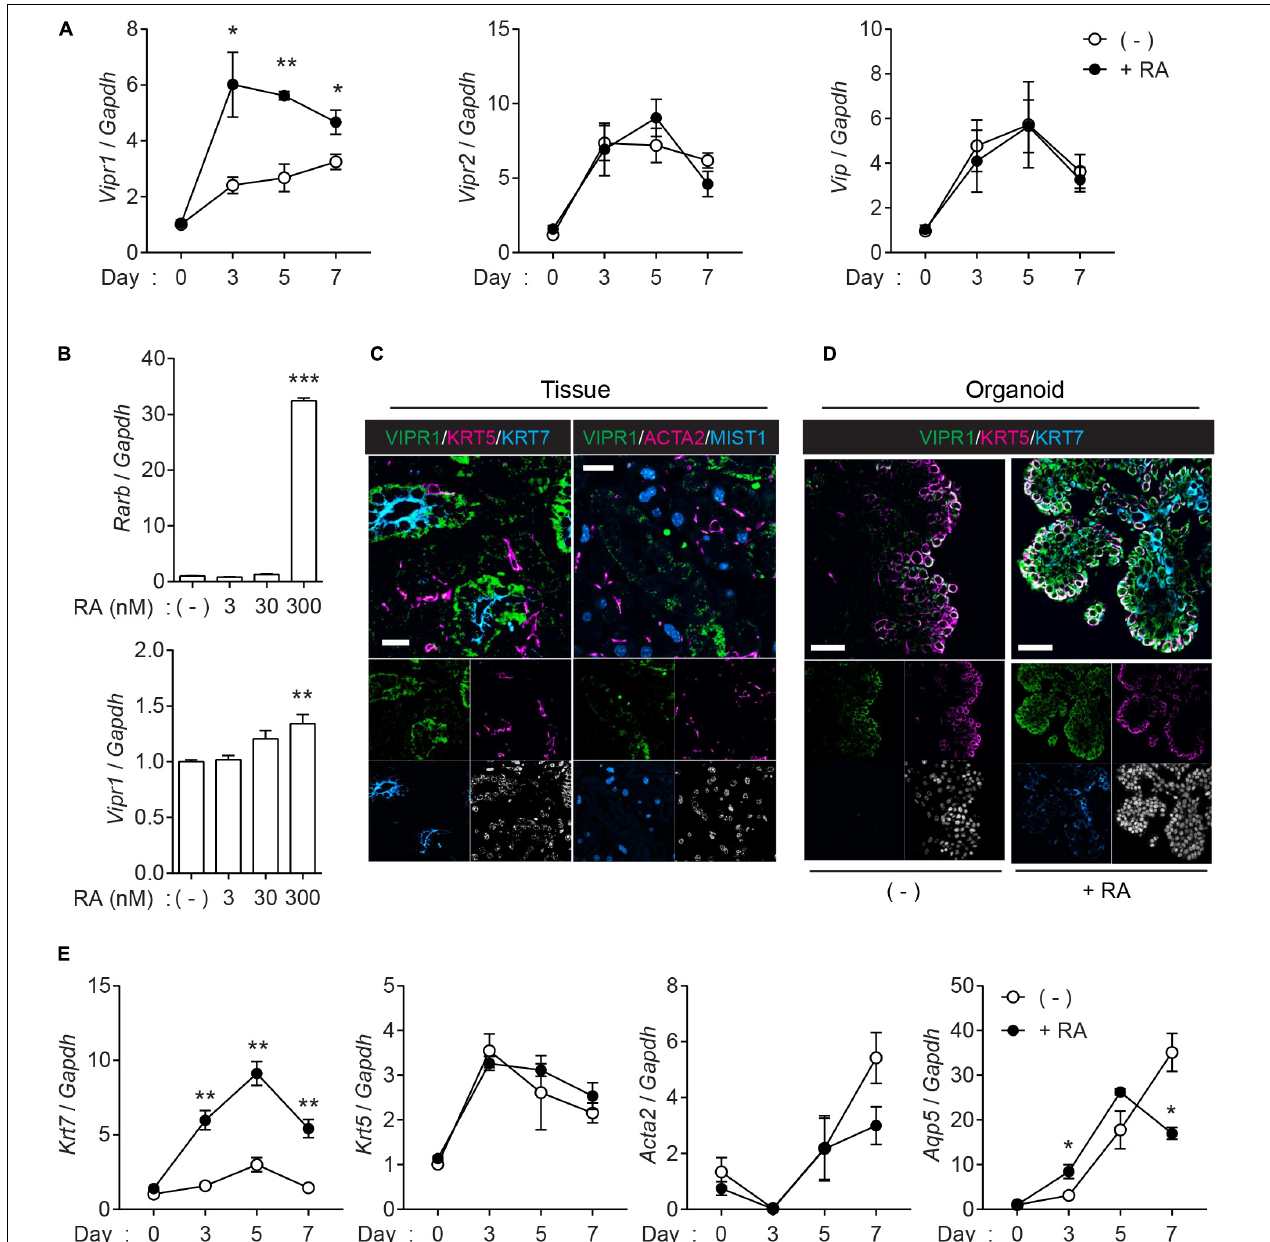
FIGURE 3 | Retinoic acid induces Vipr1 gene expression. (A) SMG organoids were treated with or without RA (300 nM) for the indicated time. After harvesting, the organoids were subjected to qRT-PCR to evaluate gene expression associated with VIP signaling ( n = 4). (B) SMG organoids were treated with varying doses of RA for 7 days and subjected to qRT-PCR for the evaluation of gene expression of Vipr1 and Rarb , a positive control, for RA-mediated signaling ( n = 4). (C) Expression of VIPR1 (green) in mouse SMG tissues (left) was assessed by co-staining with KRT5 (magenta, left), KRT7 (cyan, left), ACTA2 (magenta, right), and MIST1 (cyan, right). Nuclei were counterstained with DAPI (white) and each single channel image was placed below. Scale bars indicate 20 µ m. (D) The mouse SMG organoids cultured with (bottom) or without RA (top) were subjected to immunofluorescence for the evaluation of VIPR1 (green), KRT5 (magenta), and KRT7 (cyan) expressions. Nuclei were counterstained with DAPI (white), and each single channel image was placed below. Scale bars indicate 50 µ m. (E) The expression of several salivary gland markers in organoids treated with or without RA were analyzed using qRT-PCR at the indicated time points ( n = 4). Results are expressed as the mean ± SEM. * p < 0.05, ** p < 0.01, and *** p < 0.001. All experiments were performed at least three times